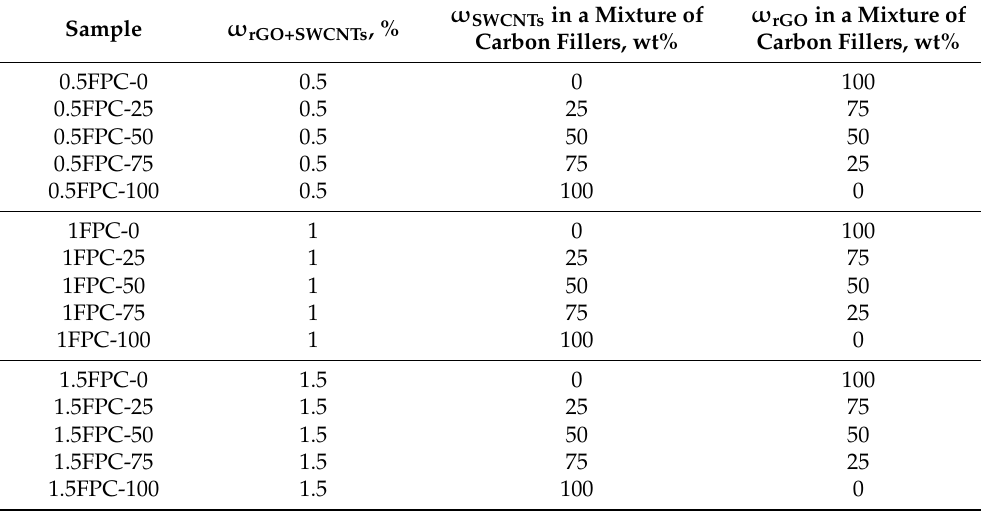
Table 1. Compositions of fabricated samples of electrically conductive composite